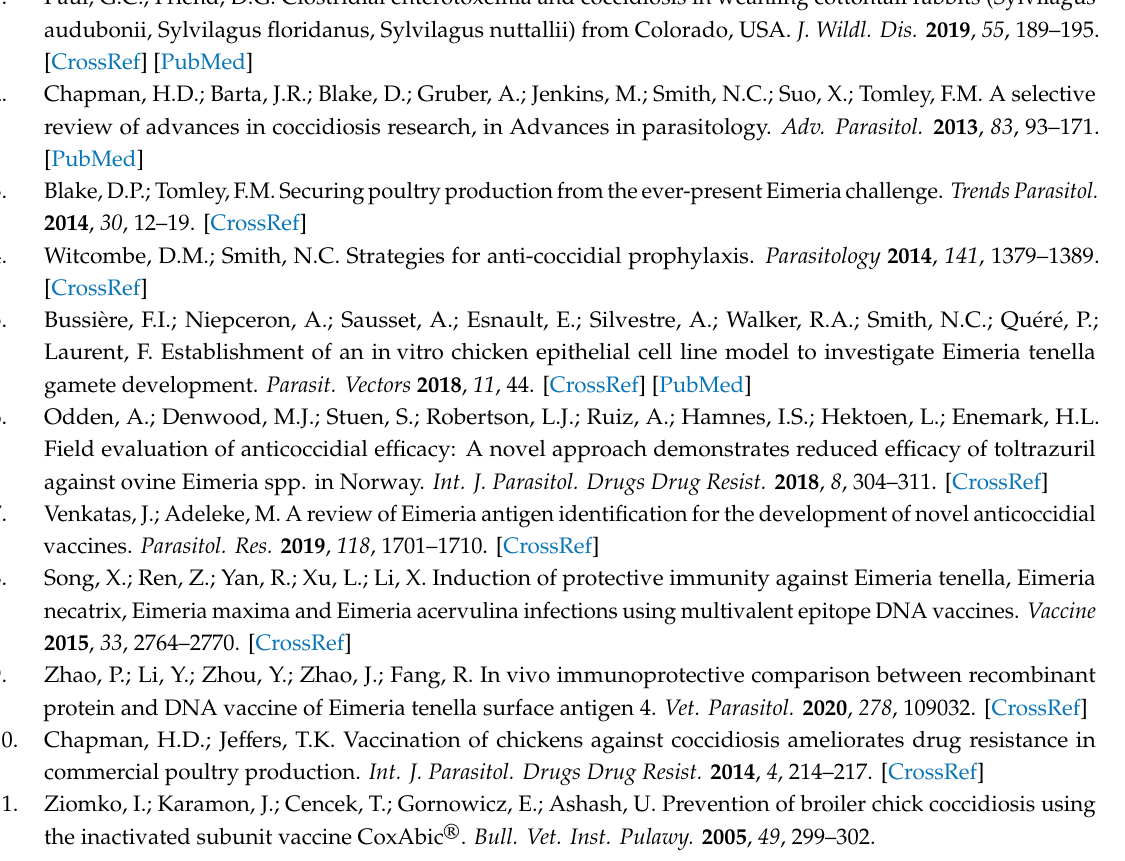
Table S1: Primers used in this study